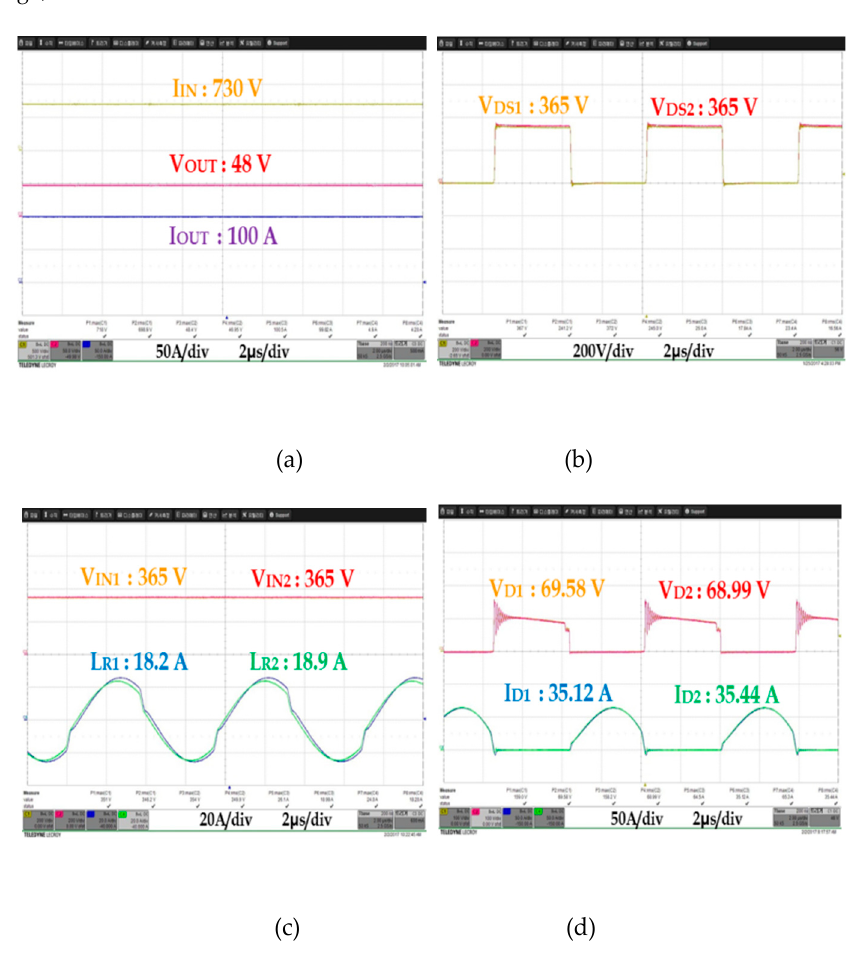
Figure 21. Experimental waveforms of the proposed converter (100% load). ( a ) Input and output voltage and output current; ( b ) FET D–S waveform; ( c ) input cap. Voltage/resonant current waveform; ( d ) Voltage/current of the rectifier diode.